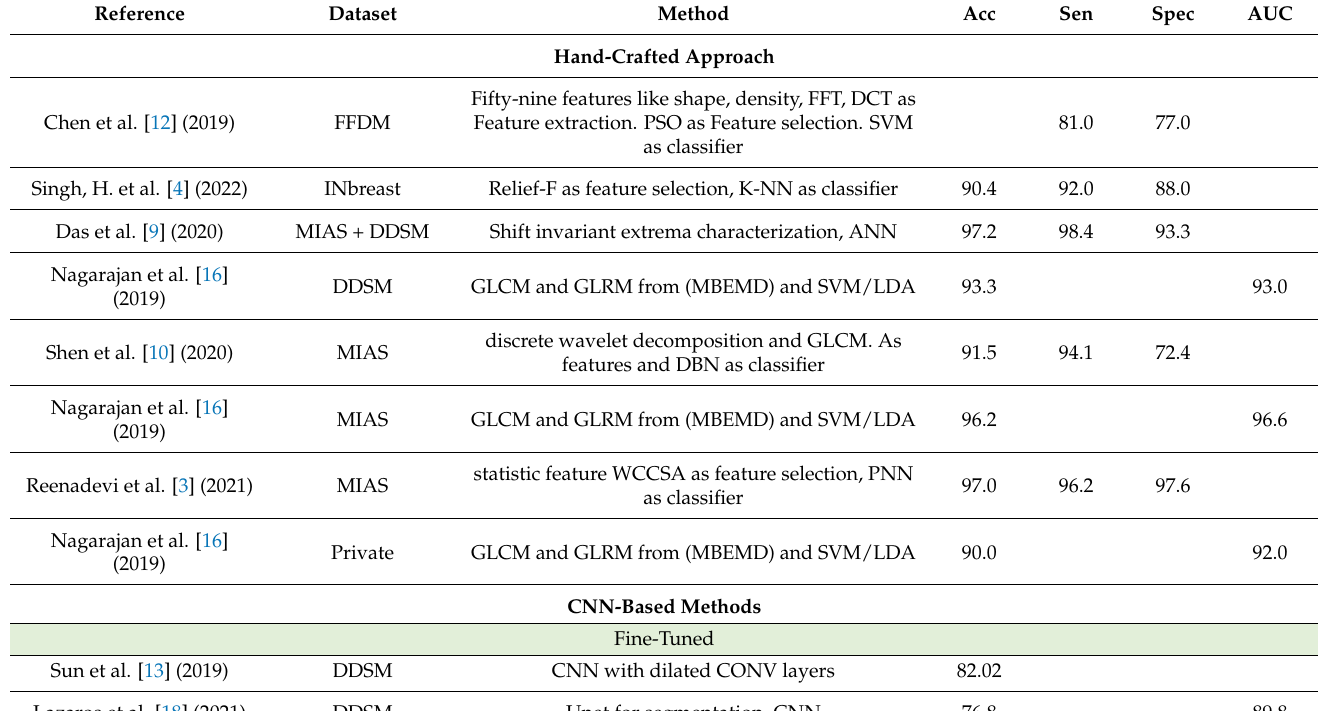
Table 1. Summary of the existing breast cancer classification